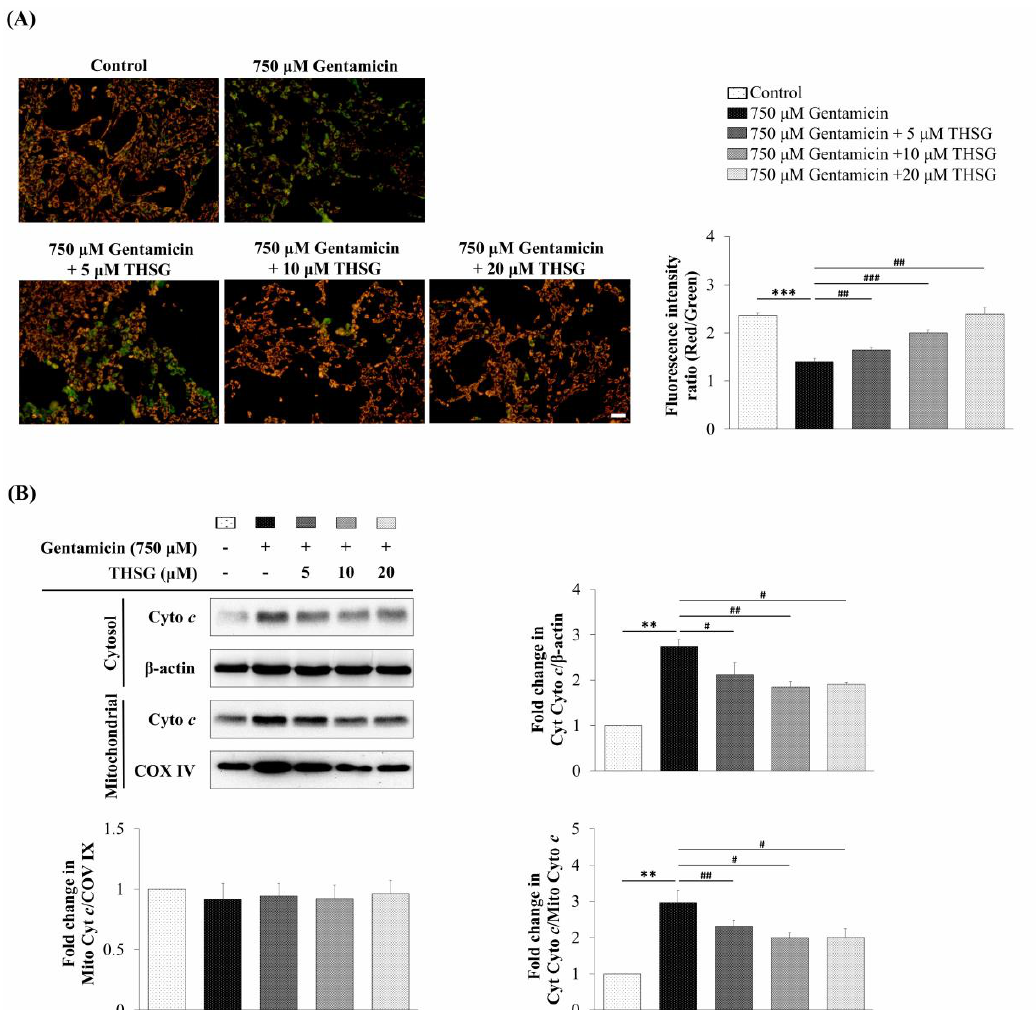
Figure 3. E ff ects of THSG on gentamicin-induced mitochondrial membrane potential and cytochrome c protein expression in mouse cochlear UB / OC-2 cells. The cells were treated with di ff erent concentrations of THSG for 6 h, followed by 750 µ M gentamicin for 24 h. ( A ) Mitochondrial membrane potential was determined by the 5,5 (cid:48) ,6,6 (cid:48) -tetrachloro-1,1 (cid:48) ,3,3 (cid:48) -tetraethylbenzimidazolylcarbocyanine iodide (JC-1) fluorescencedye.Scalebar = 50 µ m.Imageswereobtainedunderafluorescencemicroscope. ( B